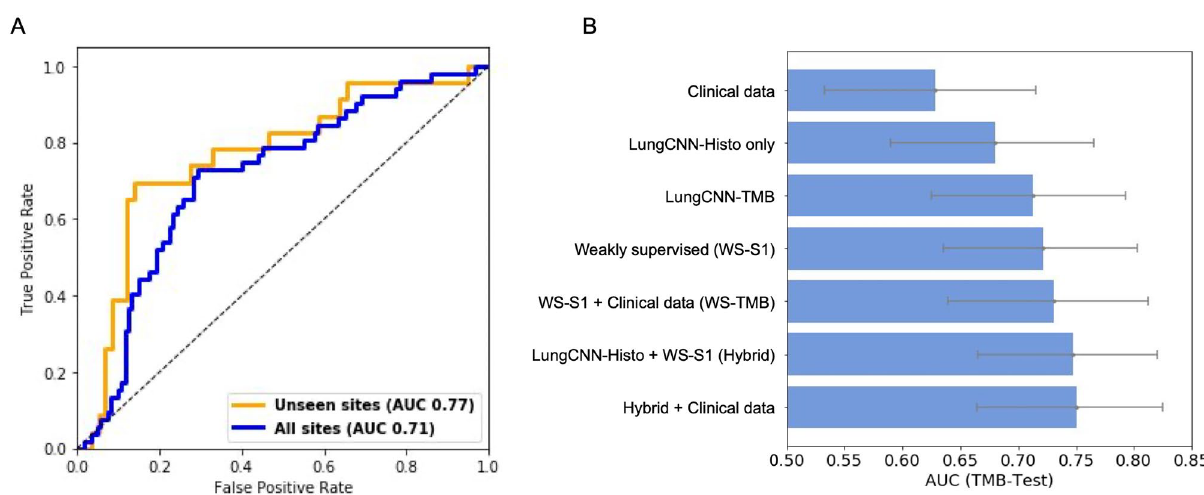
Figure 4. Model performance for classification of TMB. (A) Receiver operator characteristic curves (ROCs) and corresponding AUCs for LungCNN-TMB in predicting TMB status across all sites of the test set (blue) and the subset of cases from unseen sites (orange). (B) AUCs are plotted for TMB classification across all models developed. Clinical data plus LungCNN-Histo represents LungCNN-TMB. Error bars are 95% confidence